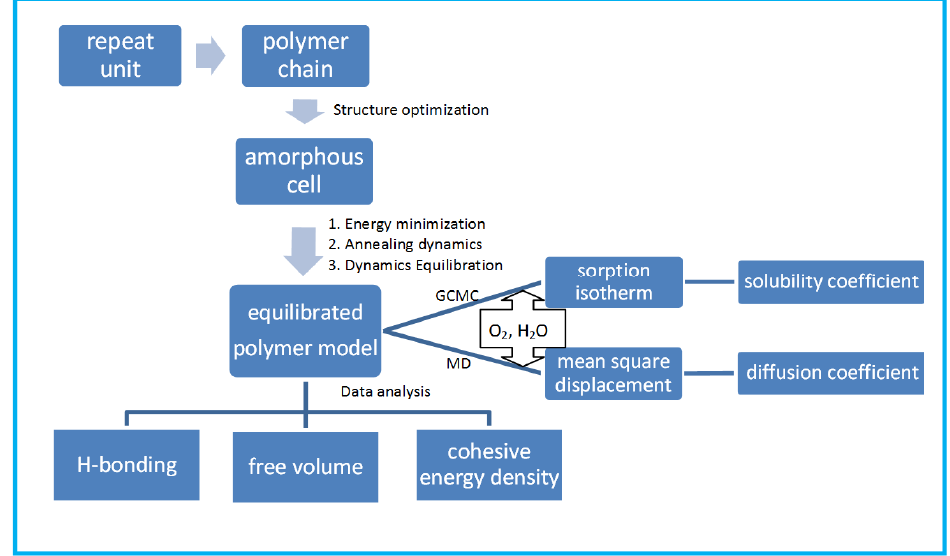
Figure 2. Molecular simulation process of polyimide (GCMC stands for Grand Canonical Monte Carlo Method, MD stands for Molecular Dynamics Simulation).